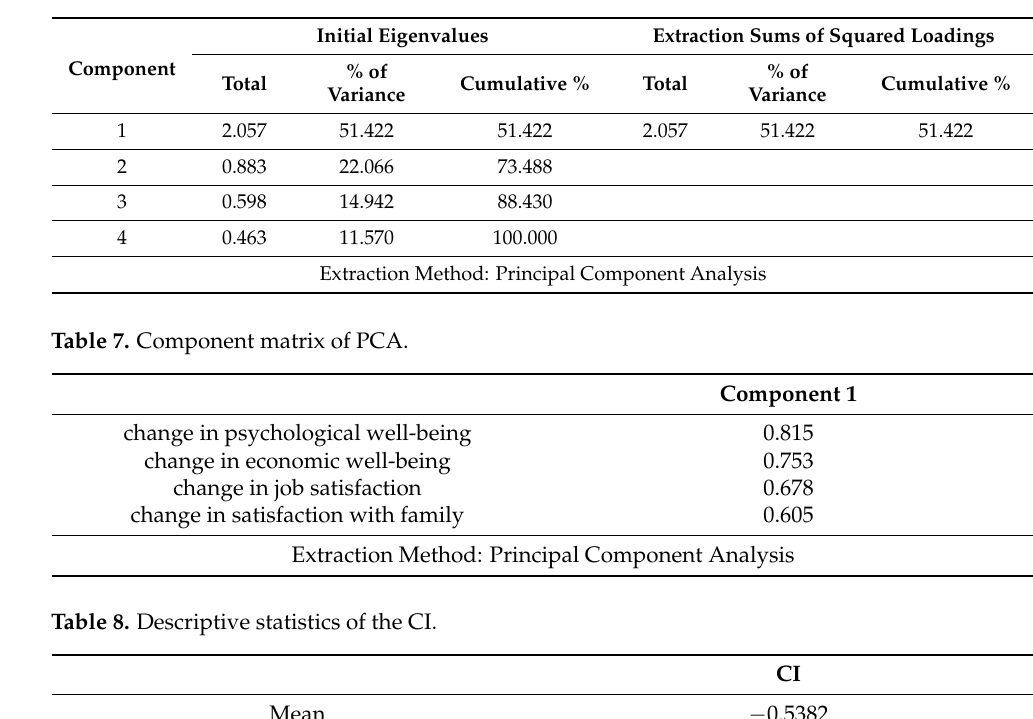
Table 6. Total variance explained of PCA.